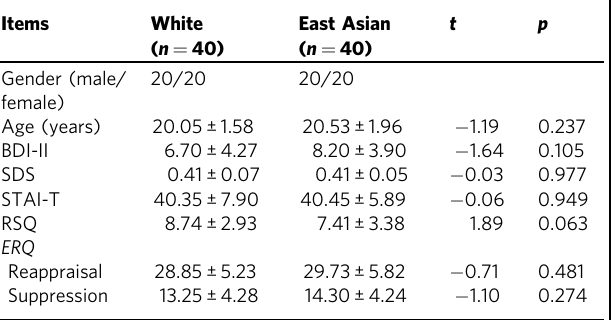
Table 1 Demographical characteristics of the two groups of participants (mean and standard deviation).